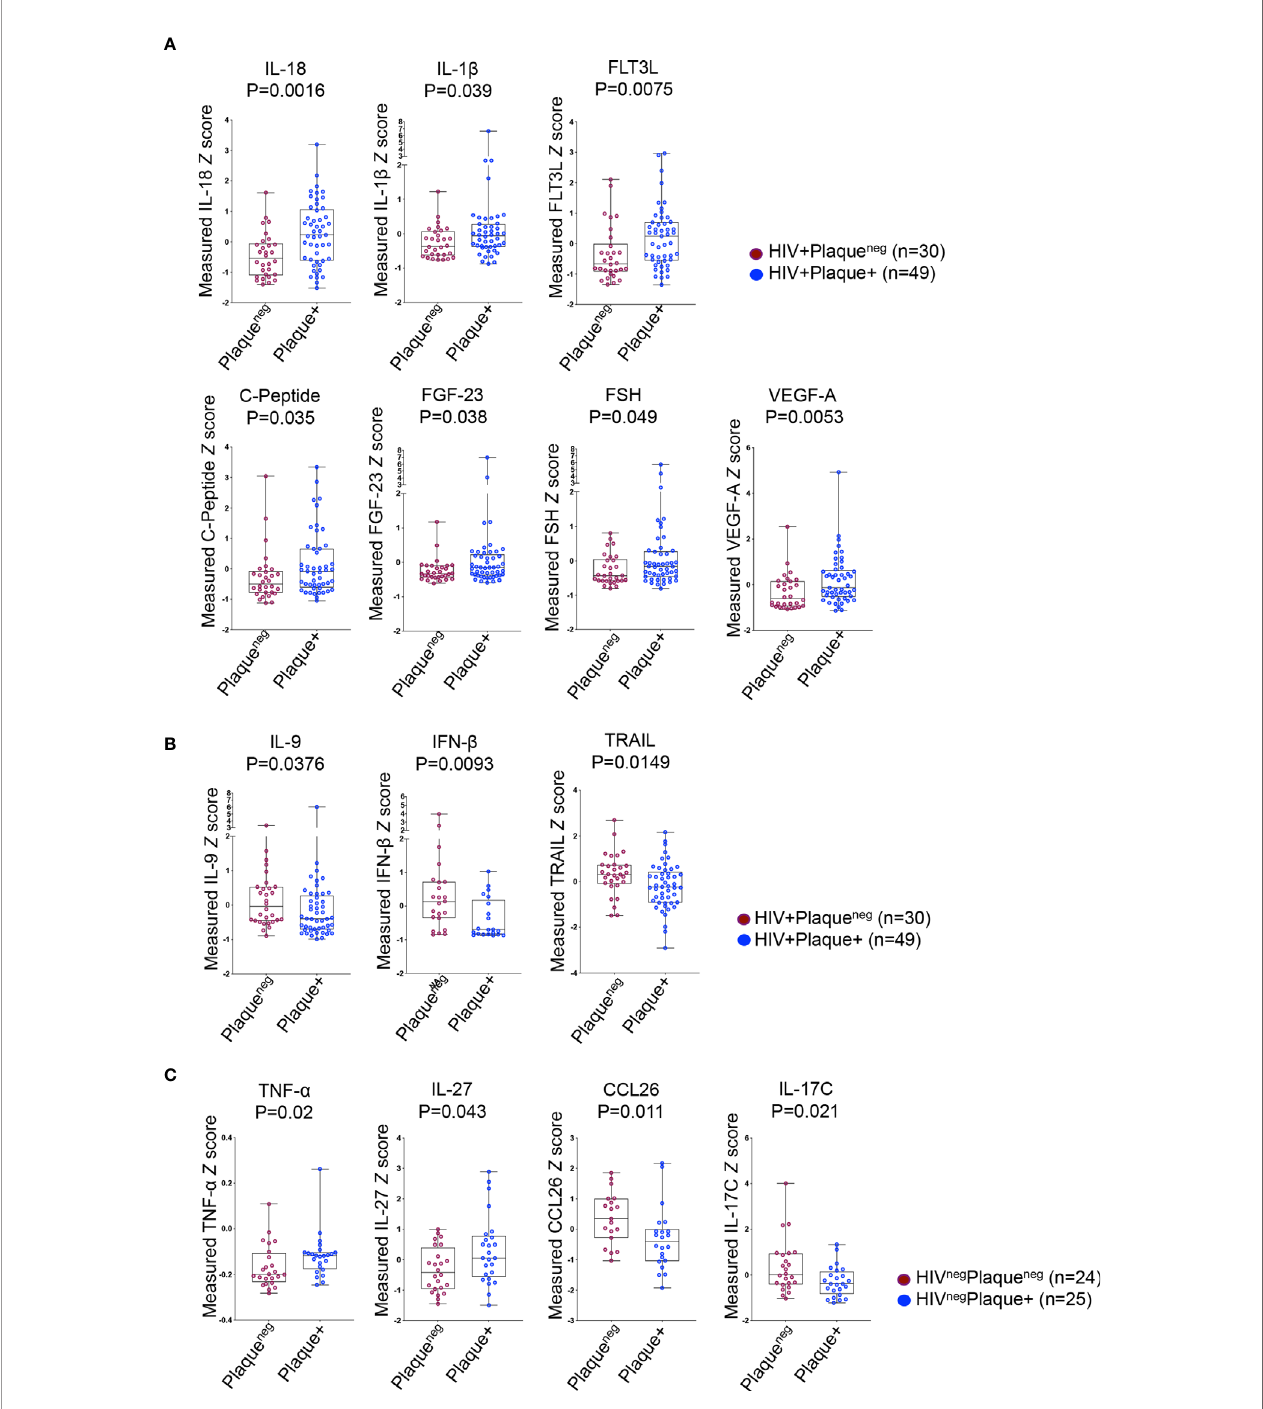
FIGURE 2 | Differentially expressed plasma analytes in HIV+ and HIV neg participants with or without subclinical atherosclerosis shown in Box-whiskers plot (min- max) of analytes Z scores. (A) Upregulated analytes in HIV+ individuals without (n=30 plaque neg ) compared to HIV+ individuals with subclinical atherosclerosis (n=49 plaque+). (B) Downregulated analytes in HIV+ individuals as in A. (C) Upregulated (left panels) and downregulated analytes (right panels) in HIV neg without (n=24 plaque neg ) compared to HIV neg individuals with subclinical atherosclerosis (n=25 plaque+). All analytes were measured with Meso Scale Discovery technology from plasma. P values are calculated with the non-parametric Mann-Whitney